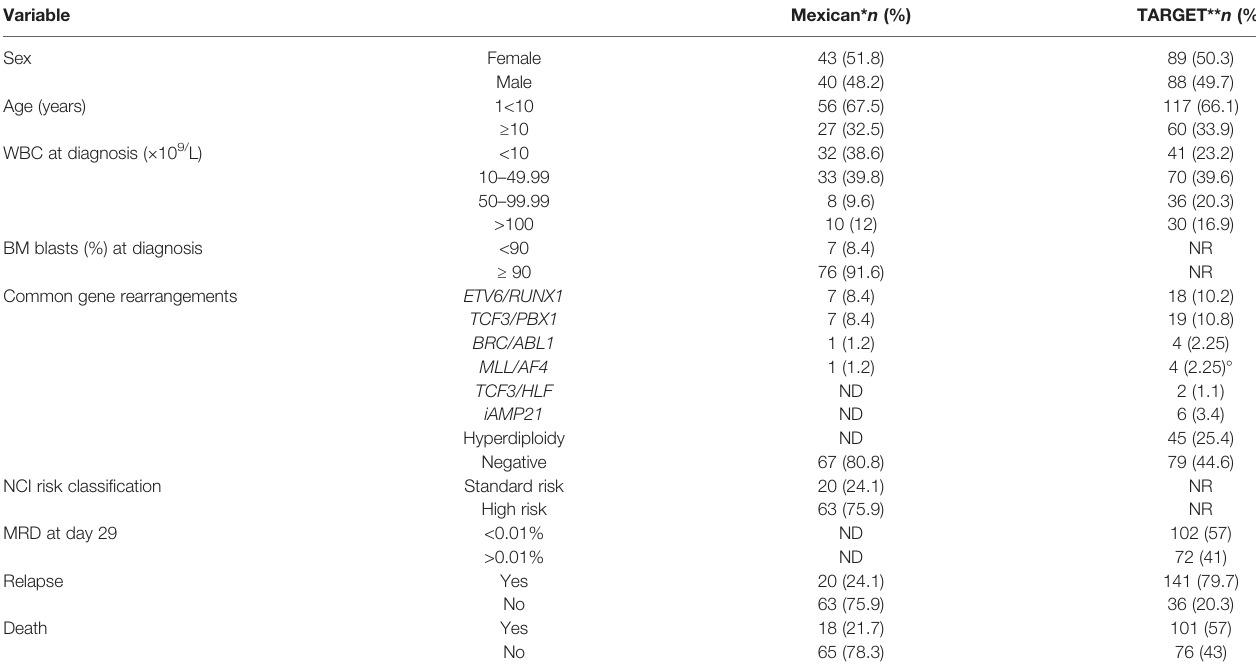
TABLE 1 | Clinical features of the studied